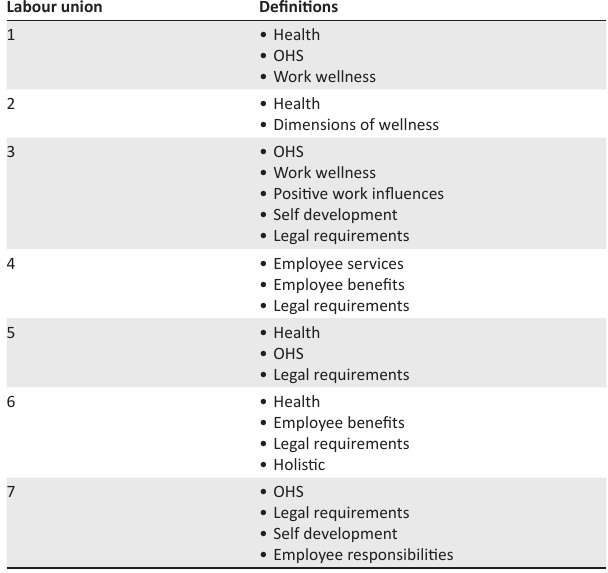
TABLE 1: Employee health according to participating organisations, service providers and labour unions. Dimension